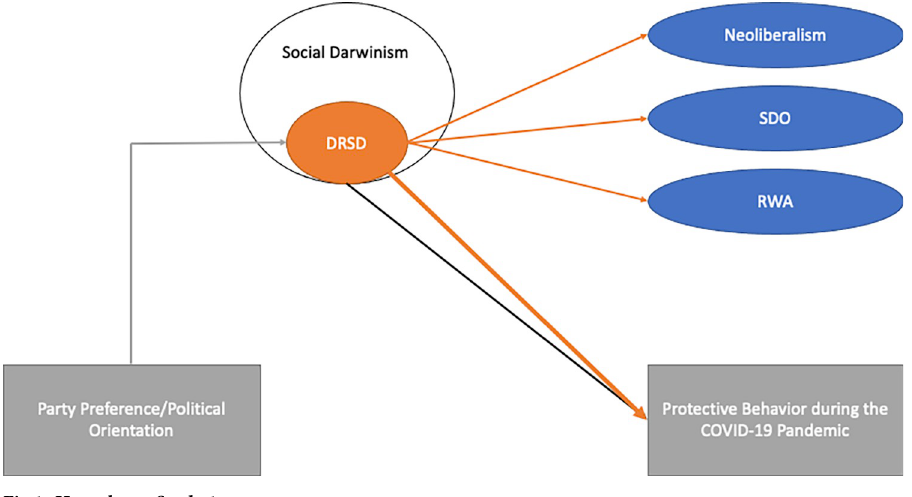
Fig 1. Hypotheses Study